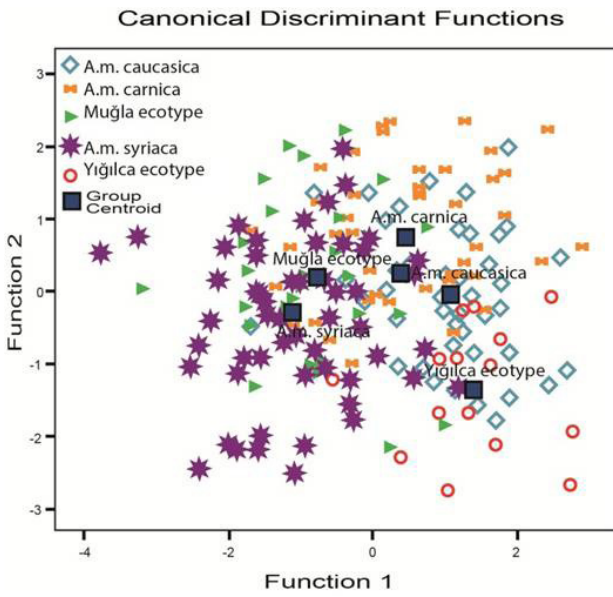
Fig 4. The discrimination of honeybee colonies from common apiary on two dimensional scatter plot by using geometric